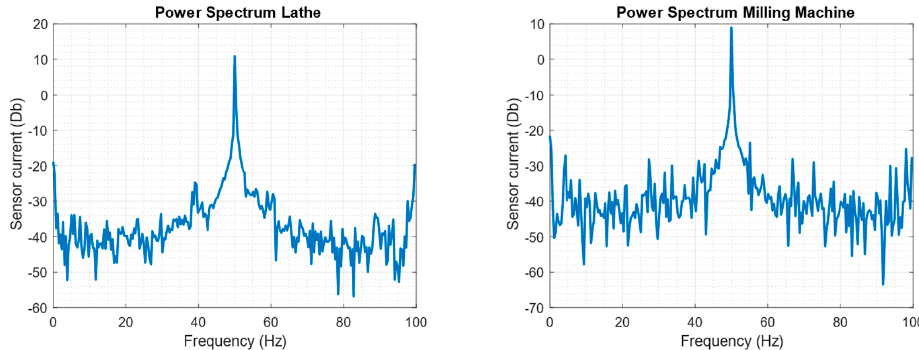
Figure 12. Power spectrum of the lathe ( left ) and the milling machine ( right ) tested.